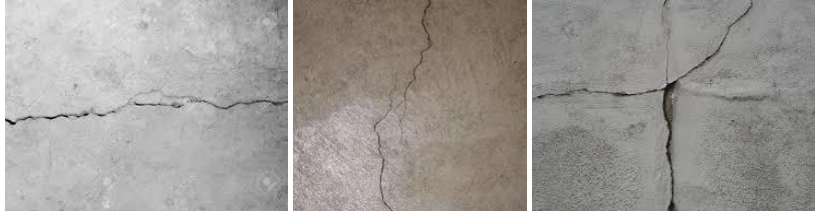
Figure 5. Example of images of concrete elements containing